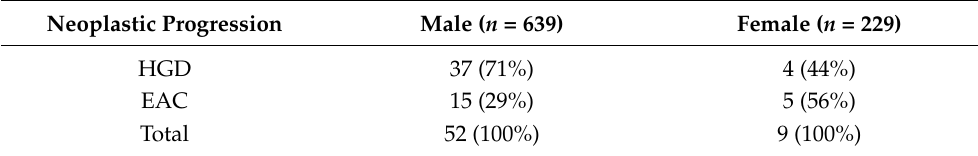
Table 2. Distribution of HGD/EAC between sexes.